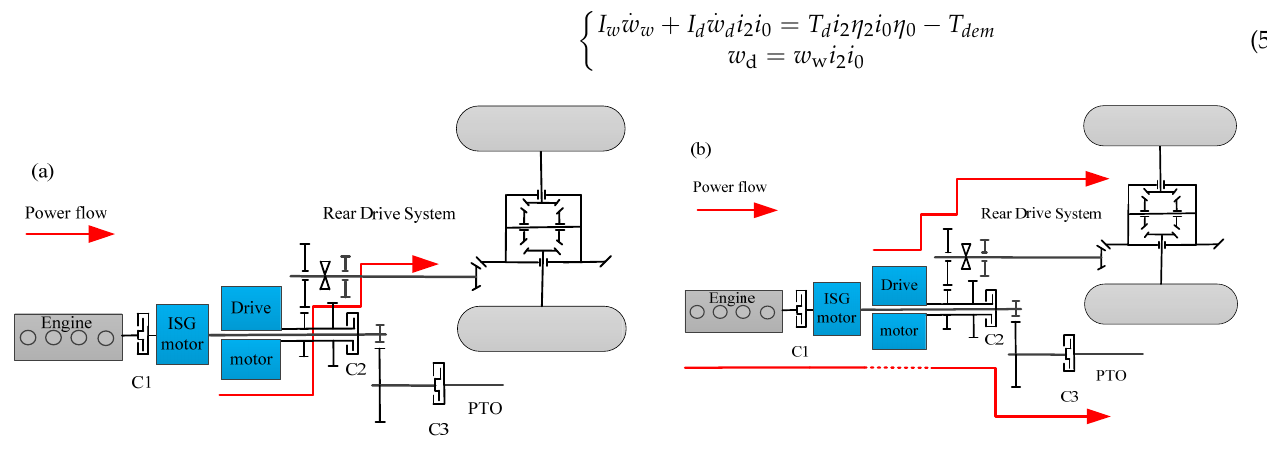
Figure 2. Power flow in SM1 ( a ) and SM2 ( b ) modes.